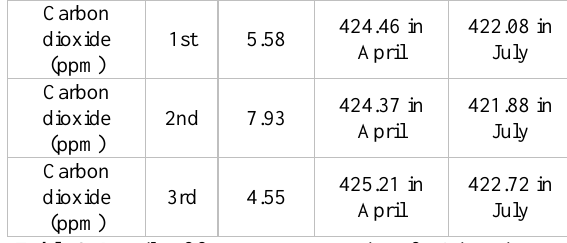
Table 3: Details of forecast concentrations for 3 iterations and respective root mean square error